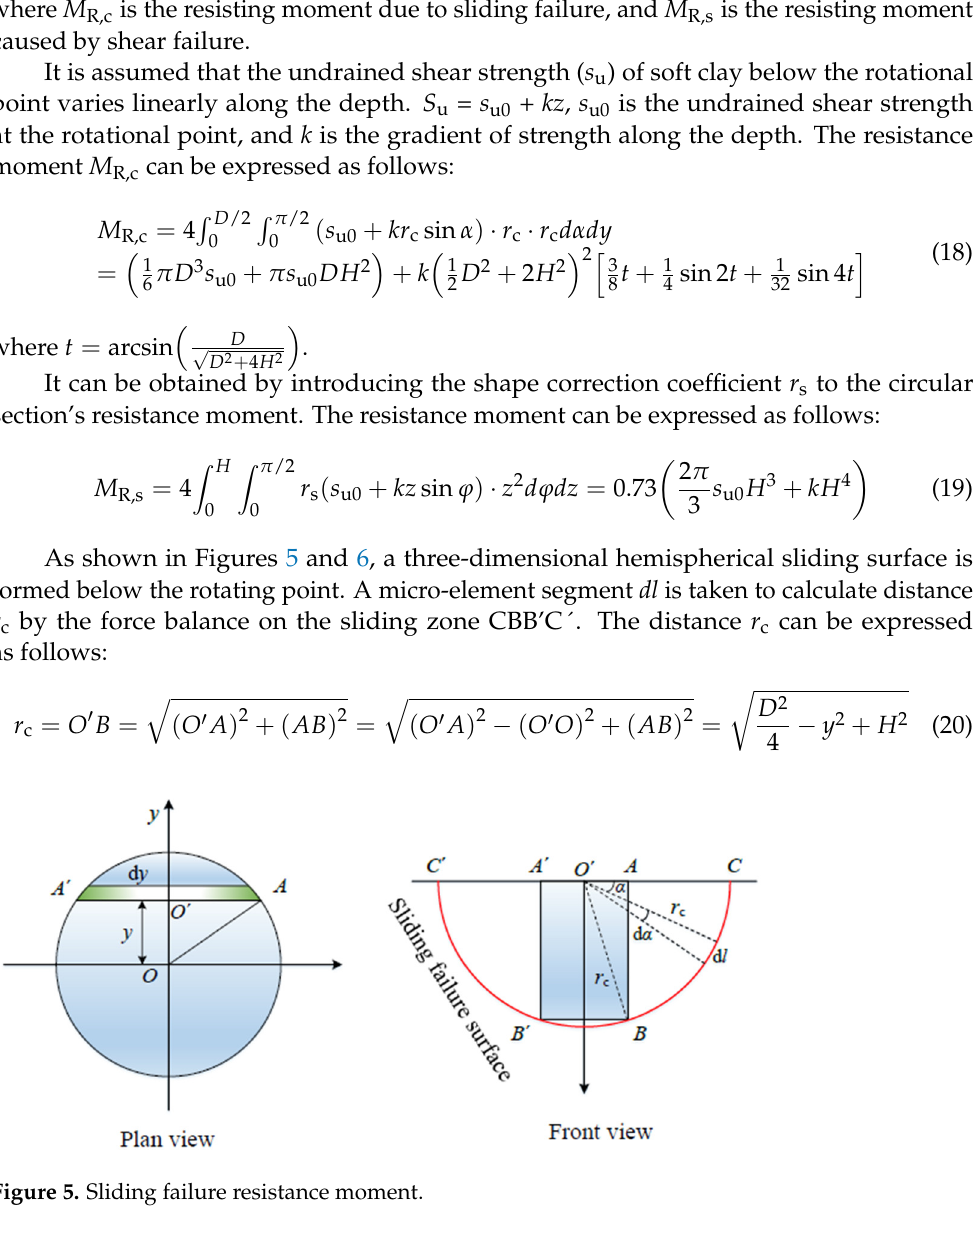
Figure 6. Shear failure resistance moment. The ultimate rotational resistance moment M R,ult is expressed as follows: 2 3